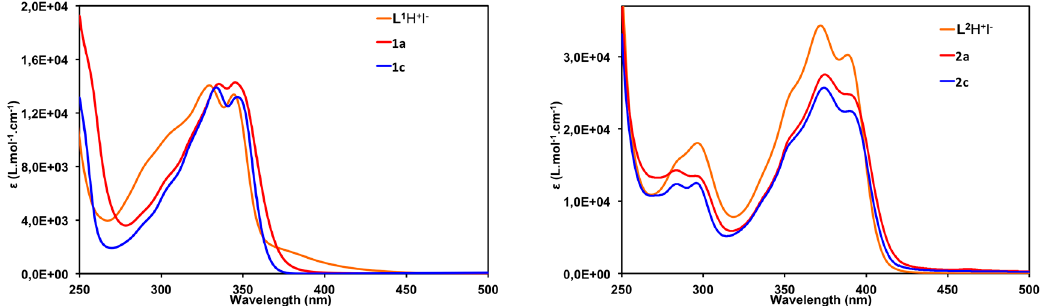
Figure 4. Absorption spectra for the azolium salts of L 1 –H + I − , L 2 –H + I − and the carbene metal complexes 1a – 2a and 1c – 2c in CH 2 Cl 2 solution at room temperature. Table 1. Absorption and emission data for the azolium salts of L 1 and L 2 , and the carbene metal complexes 1a – 2a and 1c – 2c from CH 2 Cl 2 solutions at room